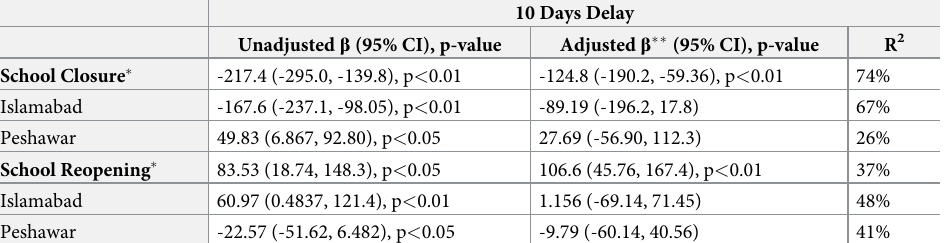
� Values are difference-in-differences showing change over time in COVID-19 incidence between Islamabad minus change over time in Peshawar. �� Adjusted for daily COVID-19 tests and with a daily time